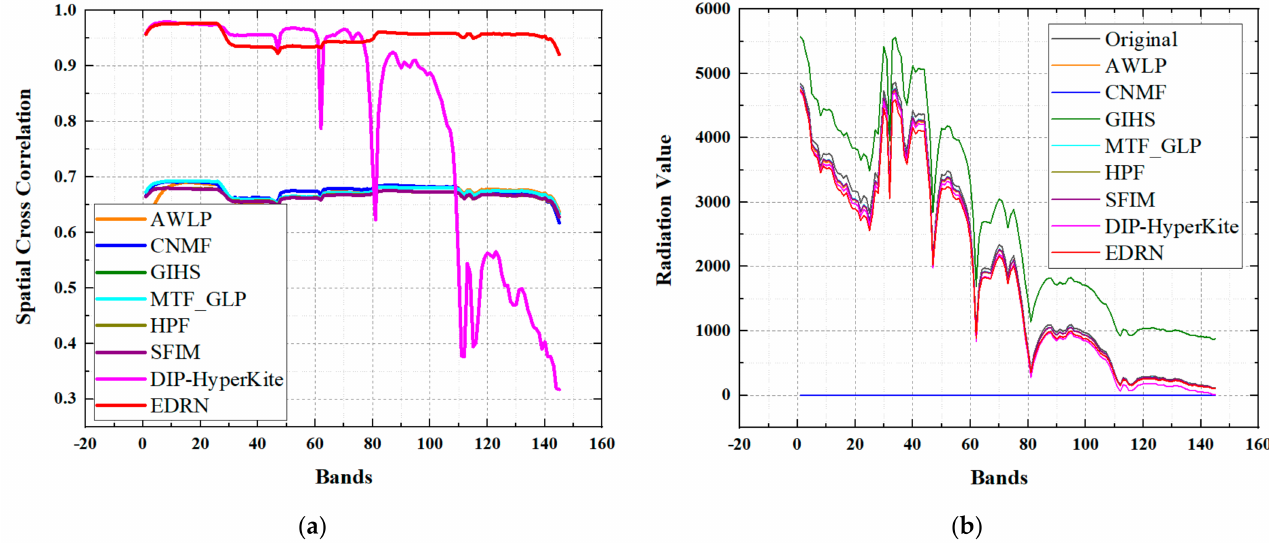
Figure 20. Quality of the compared and proposed fusion methods for the Botswana dataset: ( a ) SCC; ( b ) spectral curve